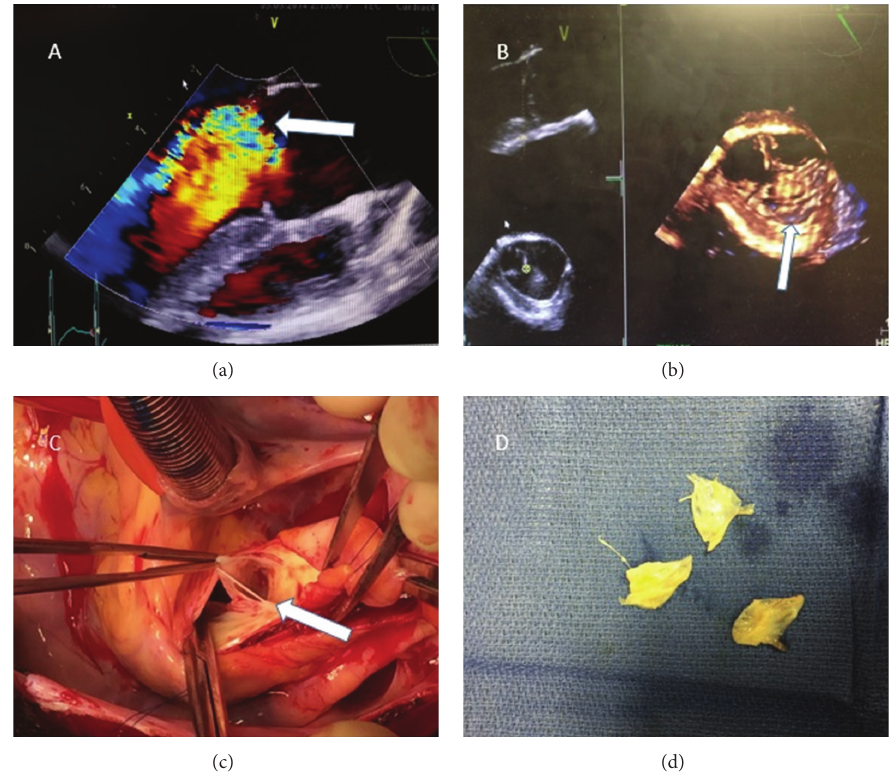
Figure 1: (a) TEE with color Doppler showing moderate to severe aortic regurgitation. (b) 3D by TEE showing prolapsed right coronary cusp. (c) Intraoperative image showing perforation of the left coronary cusp. (d) Pathologic specimen showing the three